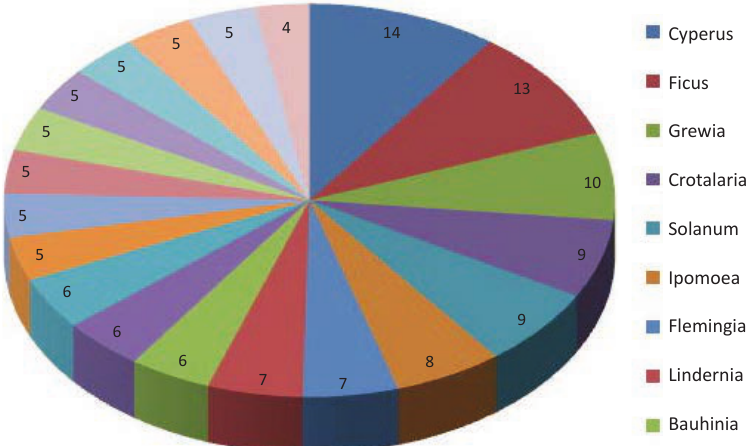
Figure 7. Largest